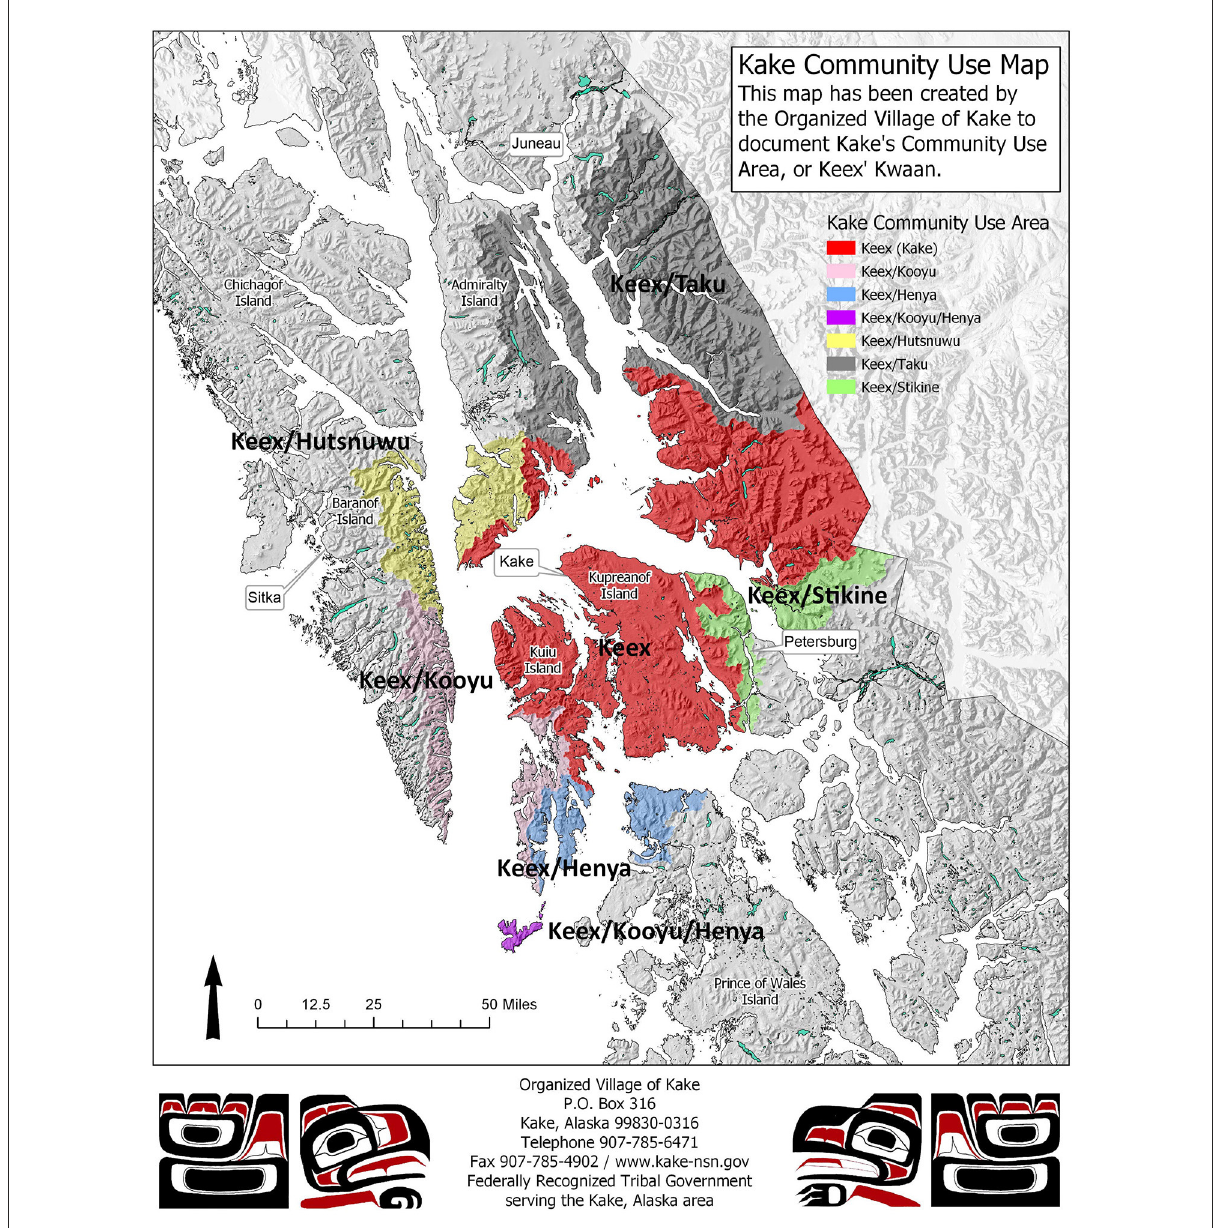
FIGURE2 Kake Community Use Map, depicting traditional harvest areas for members of the Organized Village of Kake Tribe and residents of the community of Kake. Core Keex’ Kwaan Customary and Traditional Use areas and shared areas total over 6,000,000 acres. This is a map that was created by Mike Ka.oosh Jackson (OVK Historian) and Bob Christensen (ESRI GIS